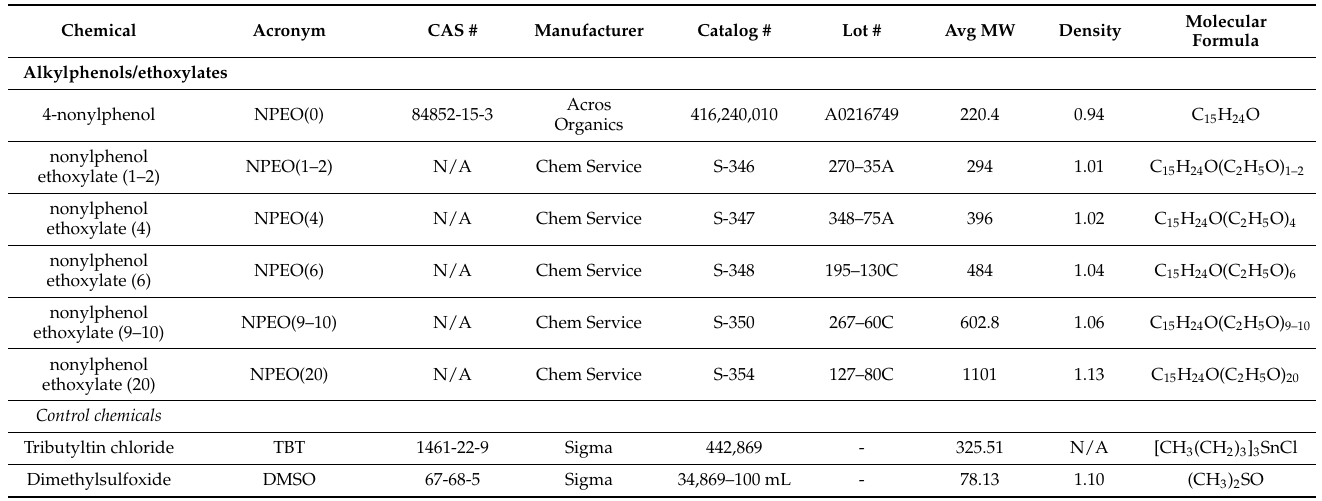
Table 1. Alkylphenol Ethoxylates and Control